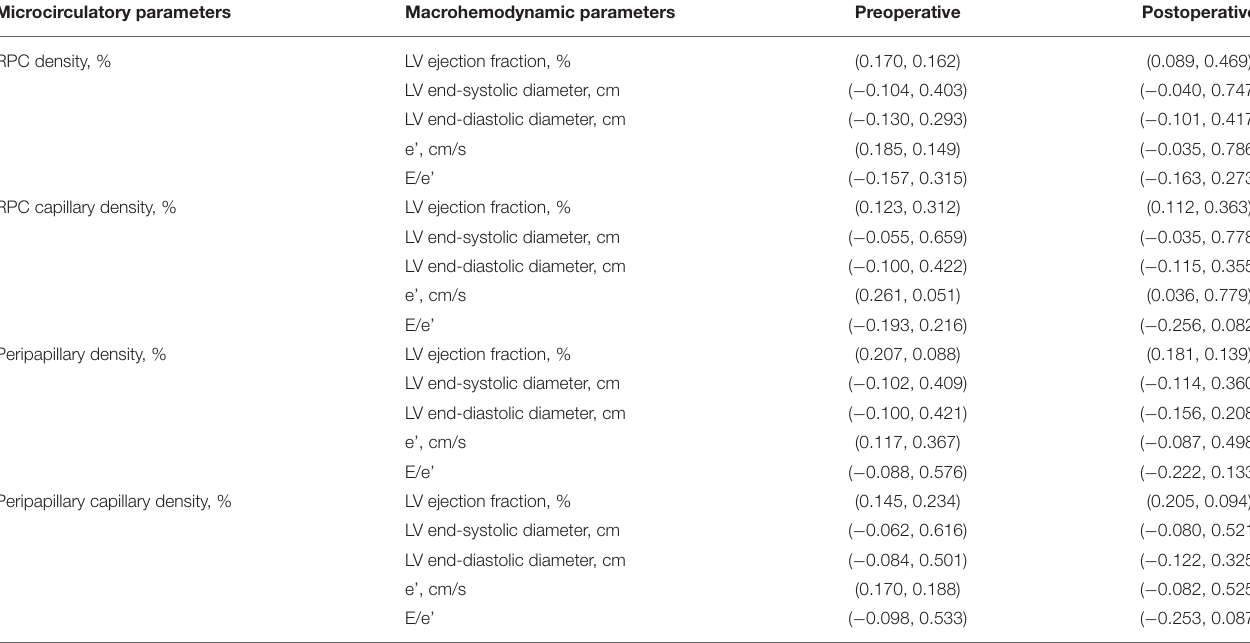
TABLE 8 | Correlation between microcirculatory and macrohemodynamic parameters in CHD patients. Microcirculatory